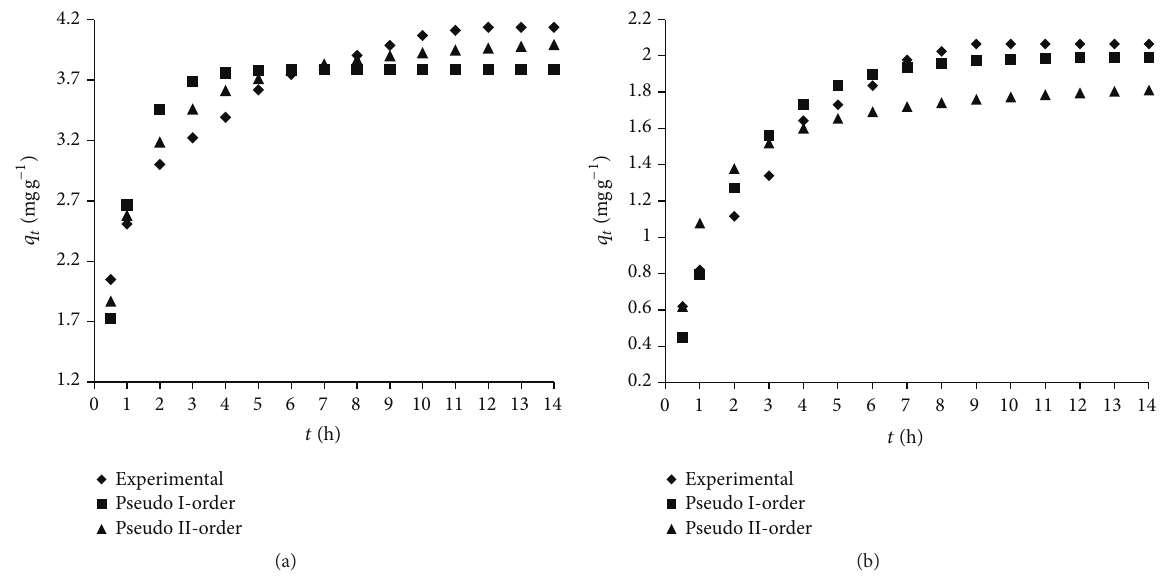
Figure 9: (a) Comparative plot of experimental and calculated value of 𝑞 𝑡 by pseudo first-order and pseudo second-order kinetic model for Cr(VI). (b) Comparative plot of experimental and calculated value of 𝑞 𝑡 by pseudo firs-order and pseudo second-order kinetic model for phenol.